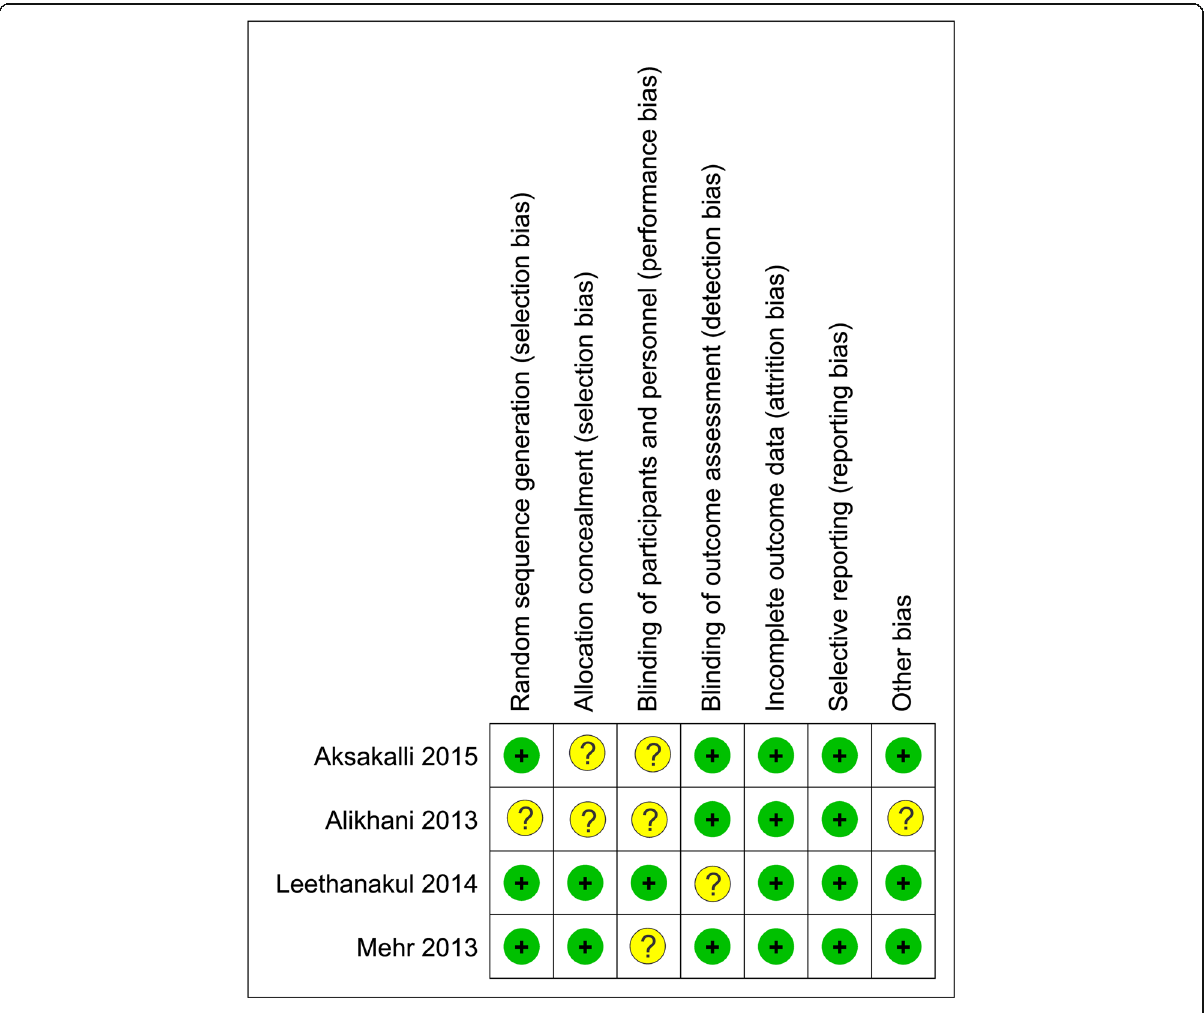
Fig. 2 Risk of bias summary of RCTs. Low risk of bias (the plus sign ); unclear risk of bias (the question mark sign